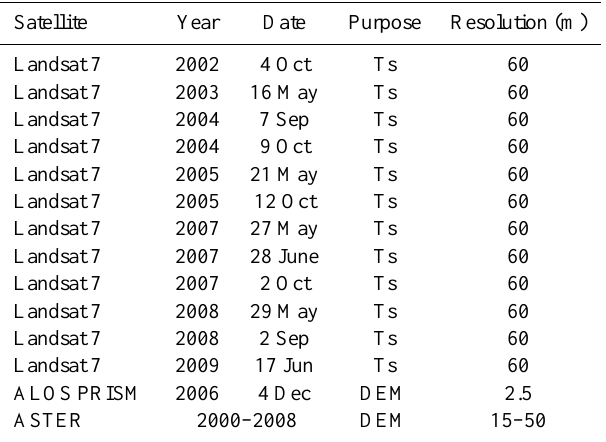
Table 1. Overview of satellite imagery used in this study.